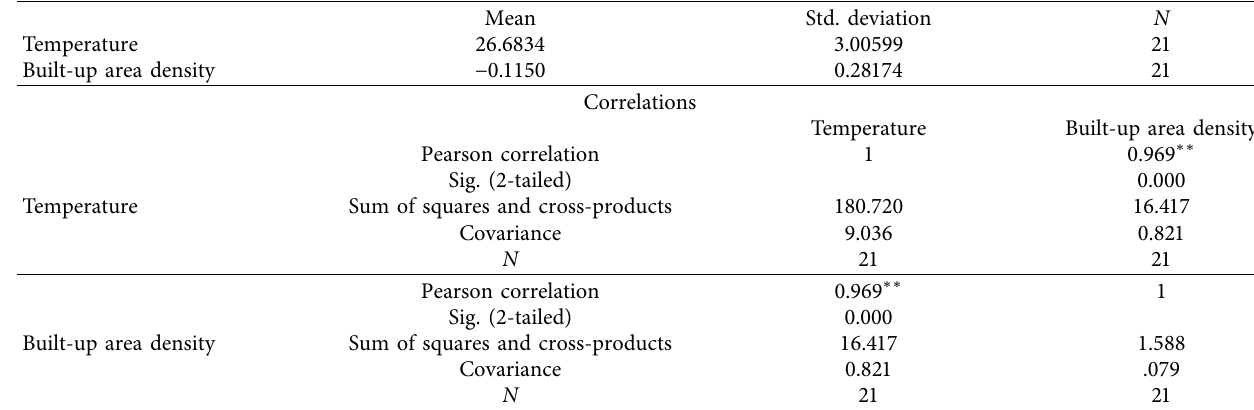
Table 6: Te correlation between surface temperature and built-up area density in Banjarmasin City in